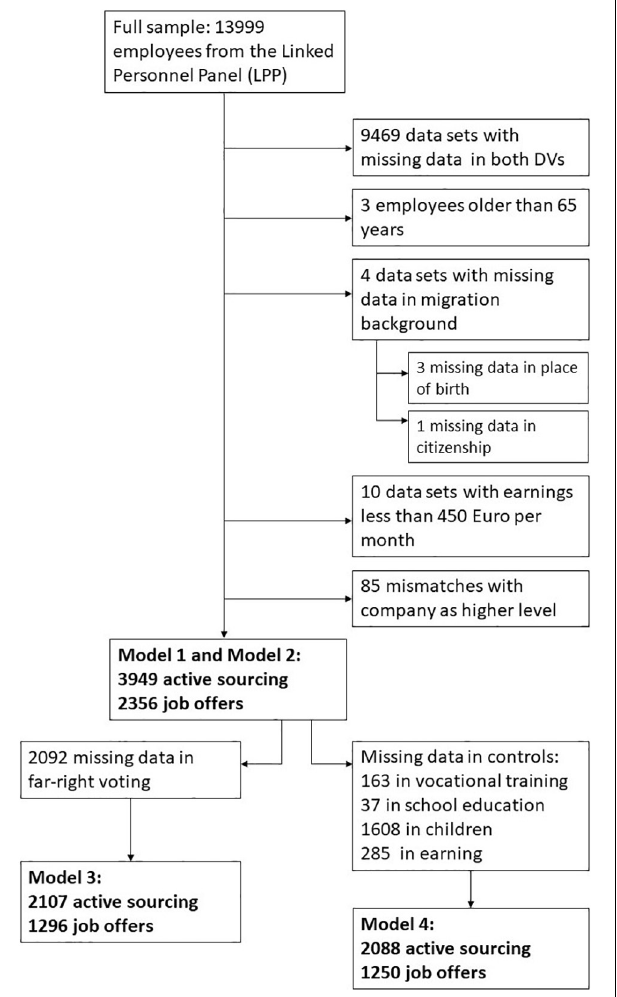
FIGURE 2 | The flow chart of the quantitative sample derived from the Linked Personnel Panel (LPP). DV = dependent variable.